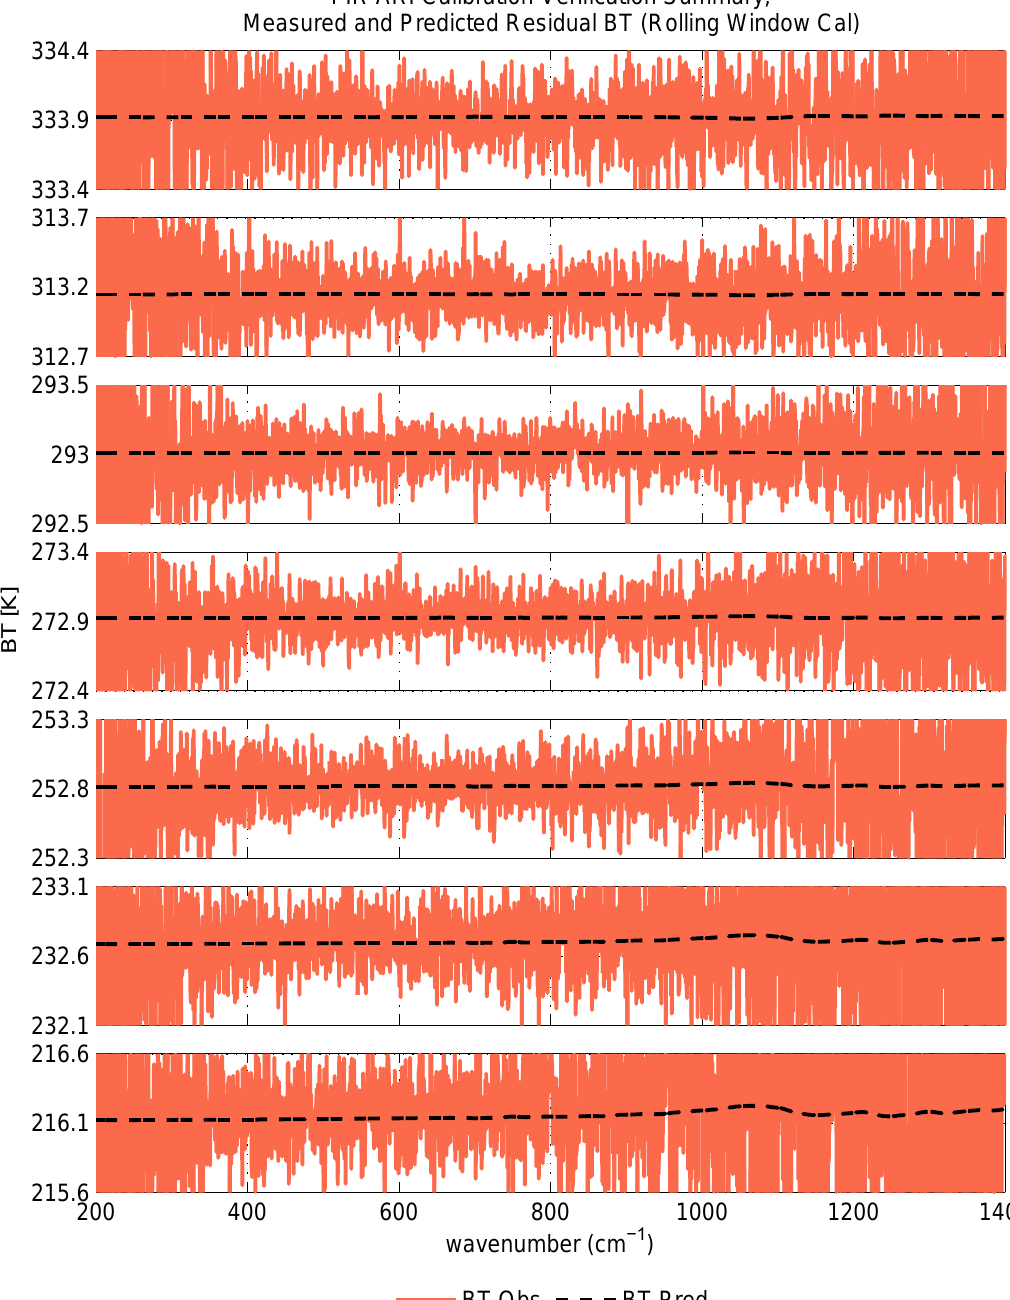
Figure 12. ARI calibration verification results for tests conducted under vacuum. Observed brightness temperature for the DTGS detector is shown in red and the black dashed line indicates predicted brightness OARS brightness temperature. The noise for the DTGS detector in the ARI prototype demonstration is significantly larger than what is expected for the flight design. Note that the brightness temperature of a real blackbody depends on both the blackbody temperature and emissivity, and for a non-ideal blackbody the brightness temperature will not be spectrally flat due to the spectral dependence of the emissivity.